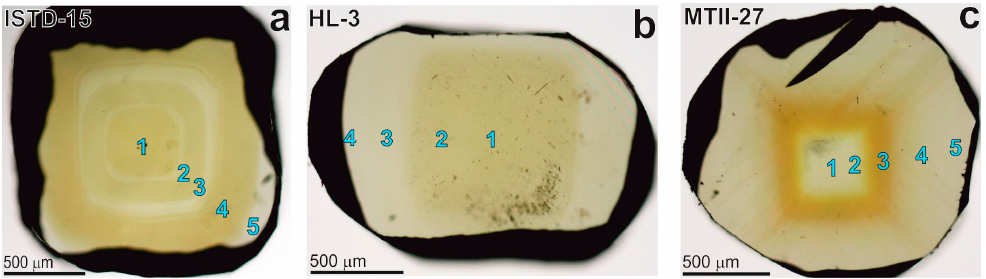
Figure 1. Polished plates of yellow cuboid diamonds from alluvial placers in the northeastern Siberian platform (transmitted light); ( a ) cubic section; ( b , c ) dodecahedron polished sections. Zoning growth structures are visible. Points in different growth zones were analyzed.